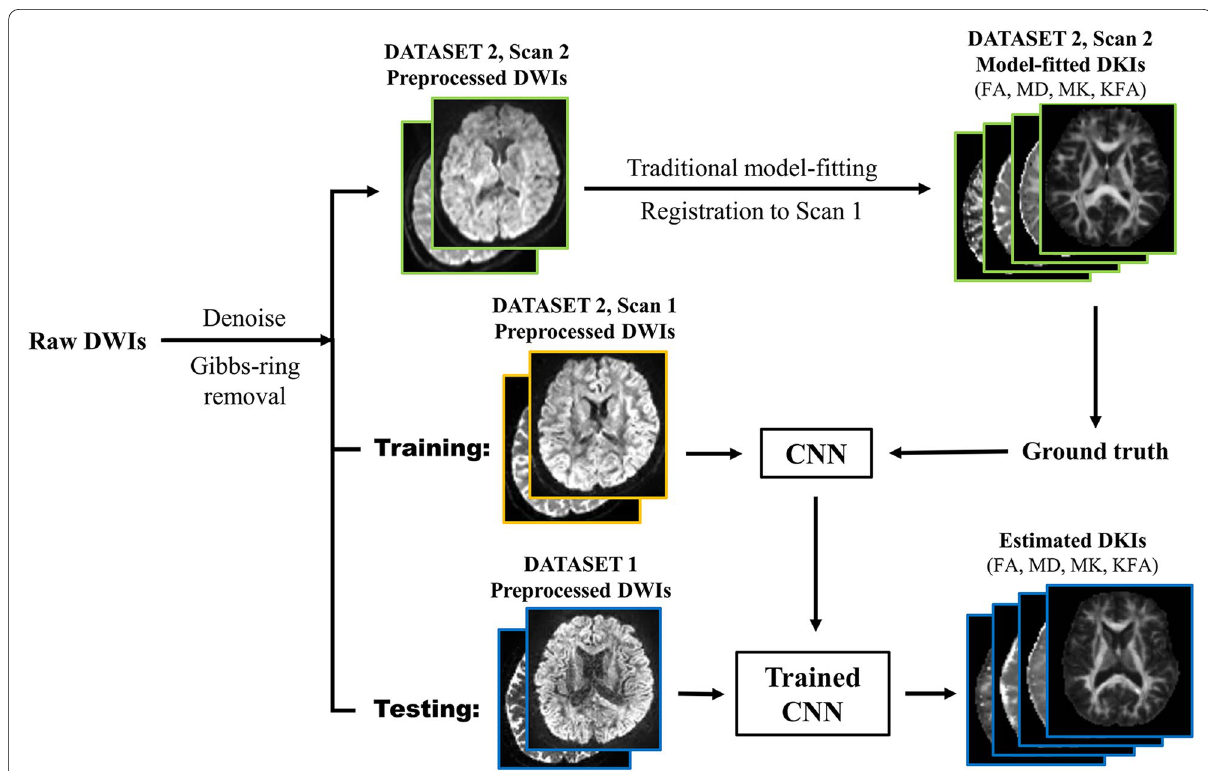
Fig. 2 The training and testing pipeline of the convolutional neural network method. Note. CNN, convolutional neural network; DWI, diffusion-weighted imaging; DKI, diffusion kurtosis imaging; FA, fractional anisotropy; MD, mean diffusivity; MK, mean kurtosis; KFA, kurtosis fractional